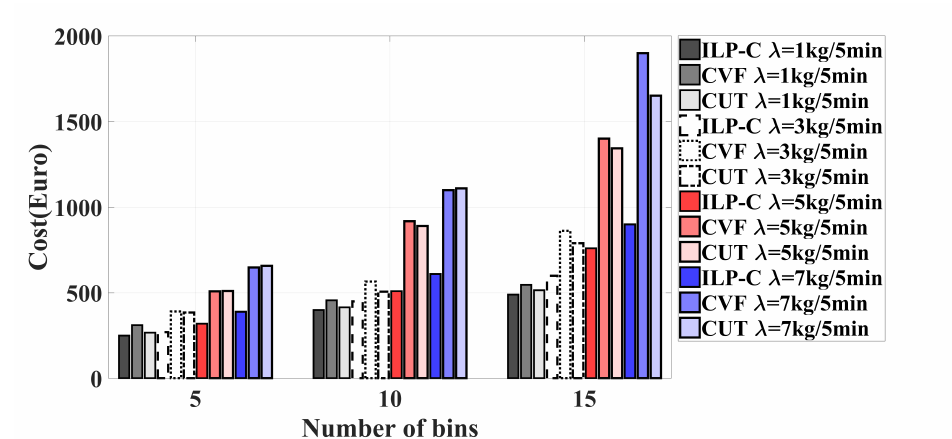
Figure 5. An overview of the system model.